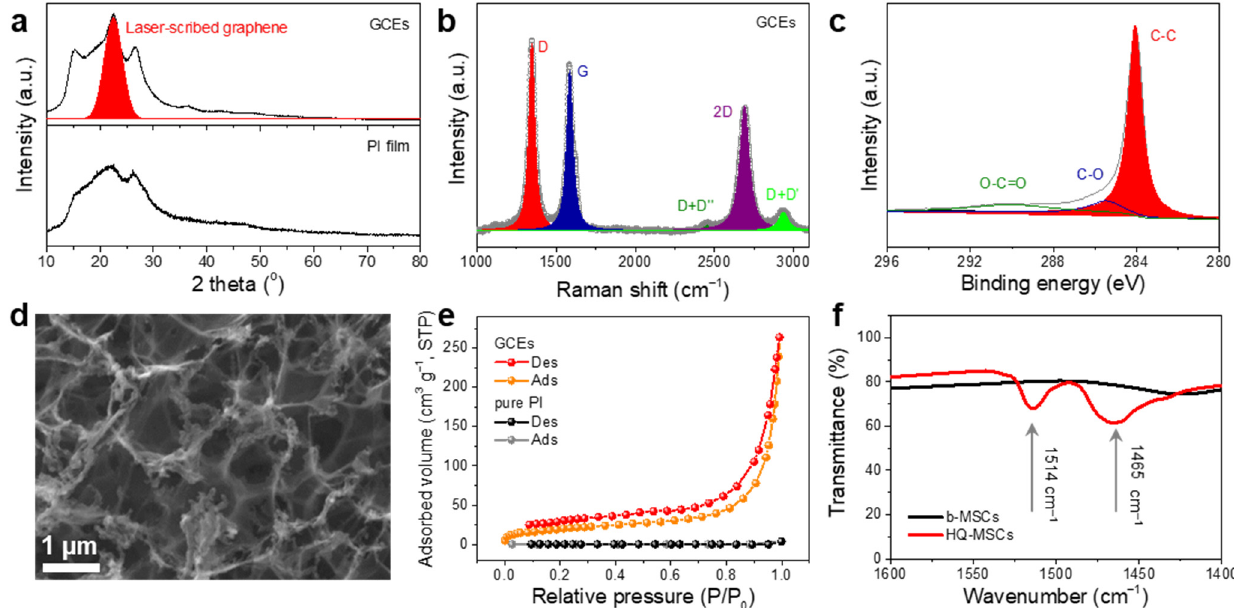
Figure 2. ( a ) X-ray diffraction (XRD) patterns of graphite-like carbon-based electrodes (GCEs) and pure polyimide (PI) film. ( b ) Raman spectrum and ( c ) X-rya photoelectron spectroscopy (XPS) C1s spectrum of GCEs. ( d ) Scanning electron microscopy (SEM) image of GCEs. ( e ) Nitrogen adsorption/desorption isotherm curves of GCEs and pure PI film. ( f ) Fourier transform infrared spectroscopy (FT-IR) spectra of HQ-MSCs and b-MSCs.